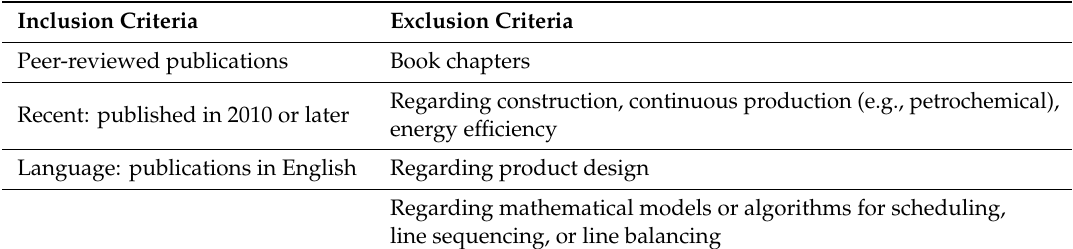
Table 2. Eligibility and exclusion